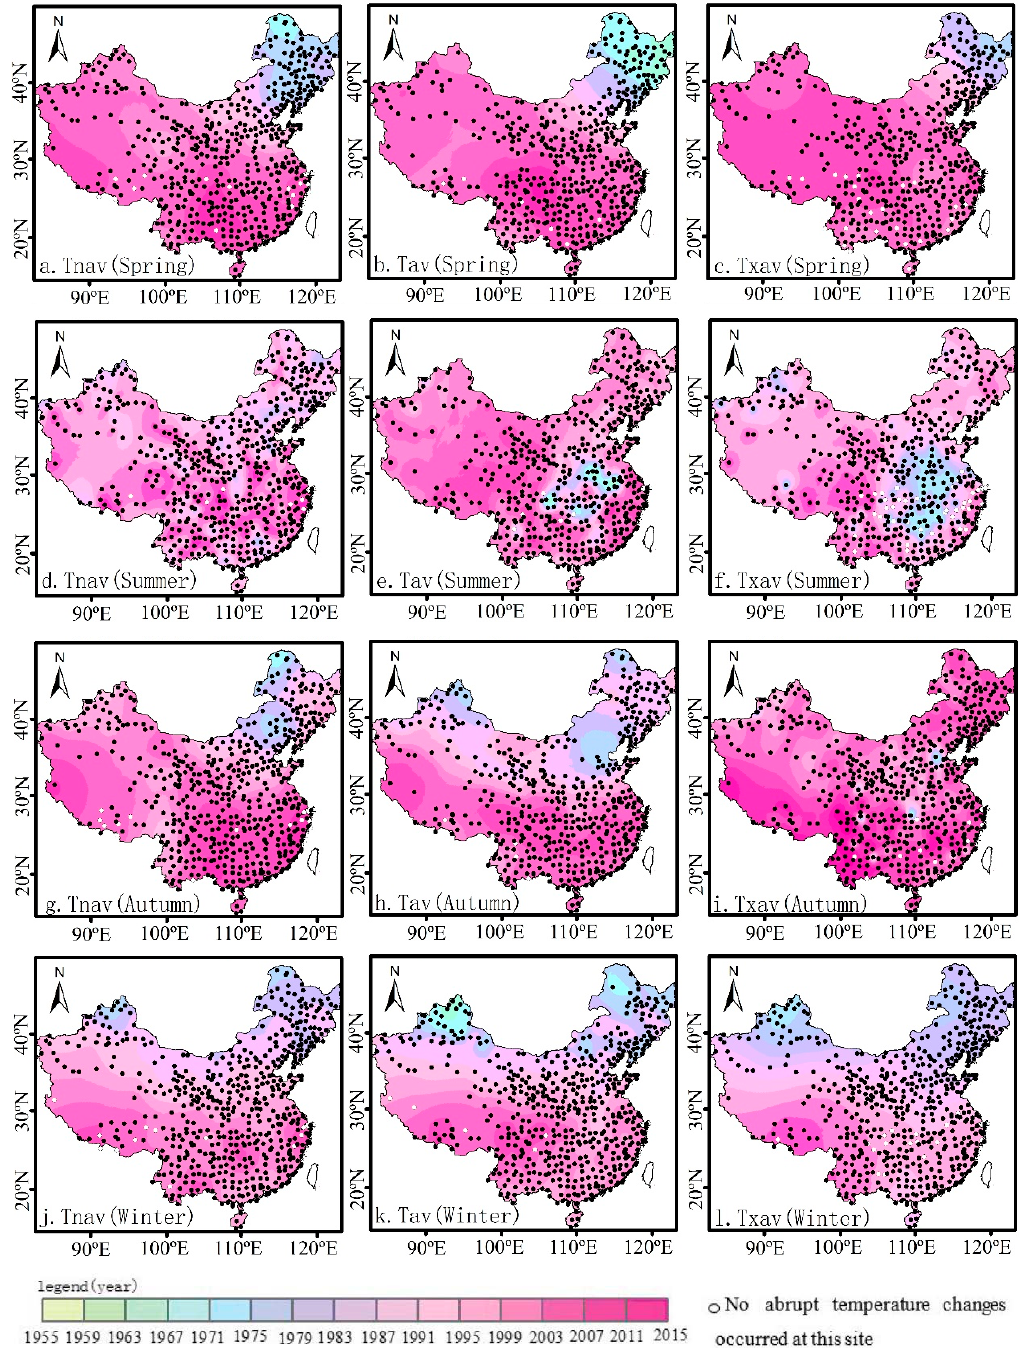
Figure 3. Spatial distribution of the years of abrupt changes in the three temperature types for each season in the study area.